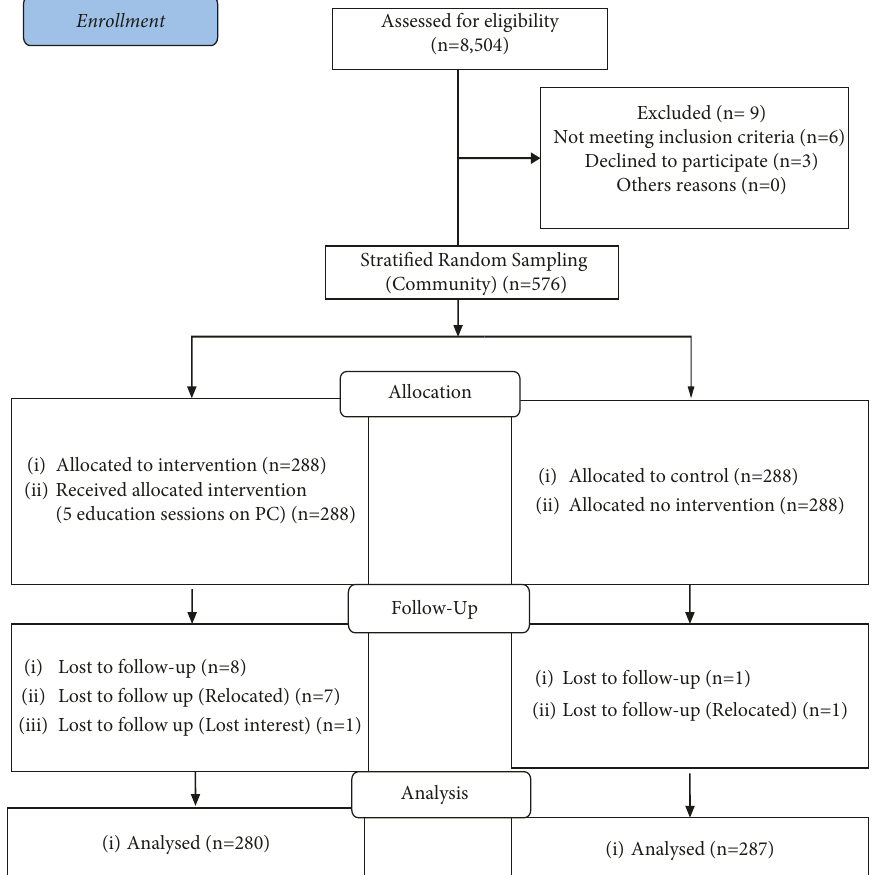
Figure 1: CONSORT diagram of study participants in the arms of the